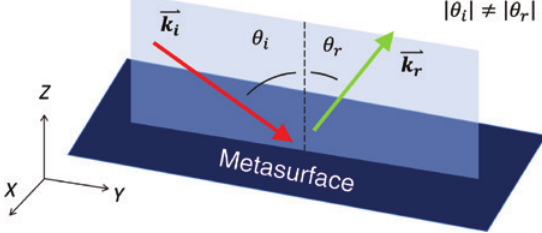
Figure 15: A schematic diagram of a perfect anomalous reflection